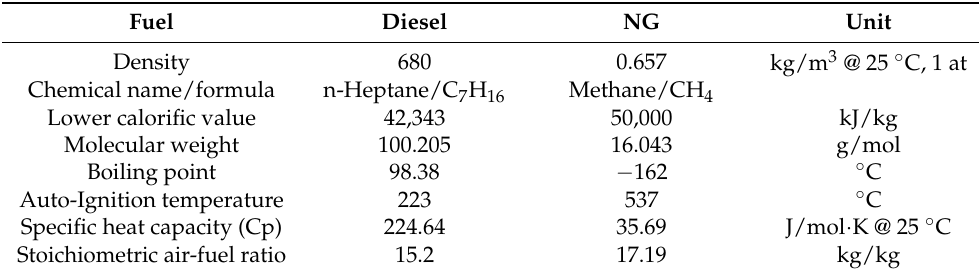
Table 4. The basic properties of the fuels